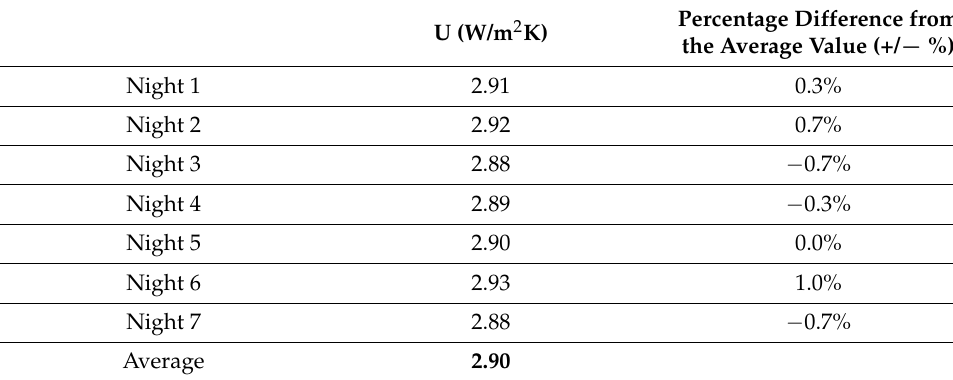
Table 3. Average nigh value of the thermal transmittance for the